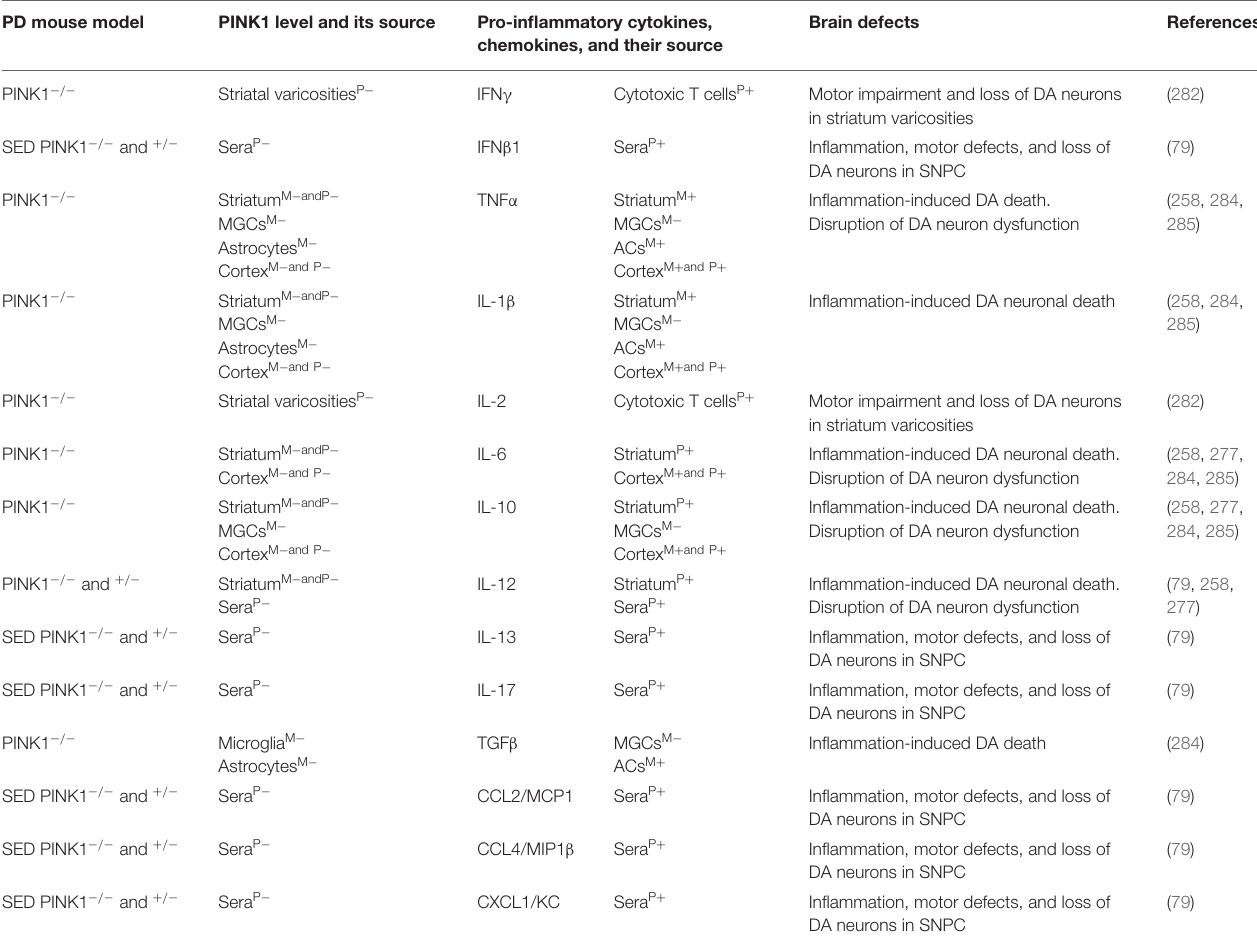
TABLE 6A | Cytokines and their source in the mouse model of PARK6 PD.